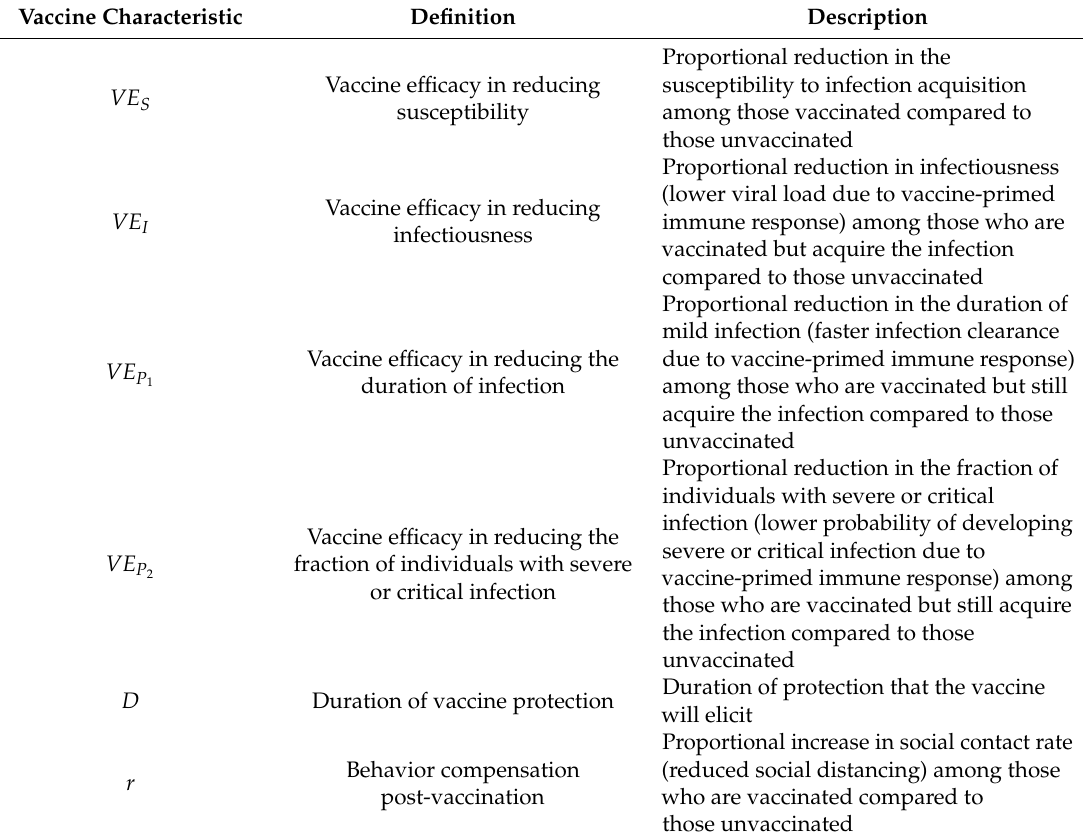
Table 1. Key vaccine product characteristics used to assess impact of a vaccine against SARS-CoV-2. Vaccine